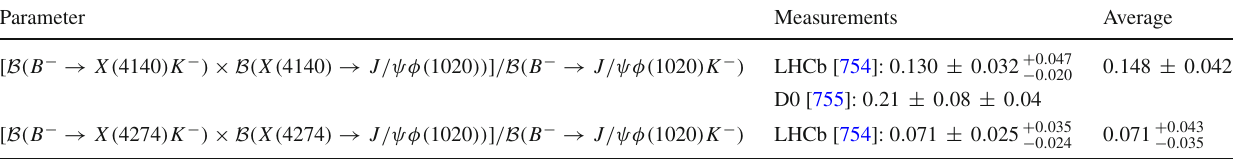
Table 177 Relative product decay rates to states with s ¯ s